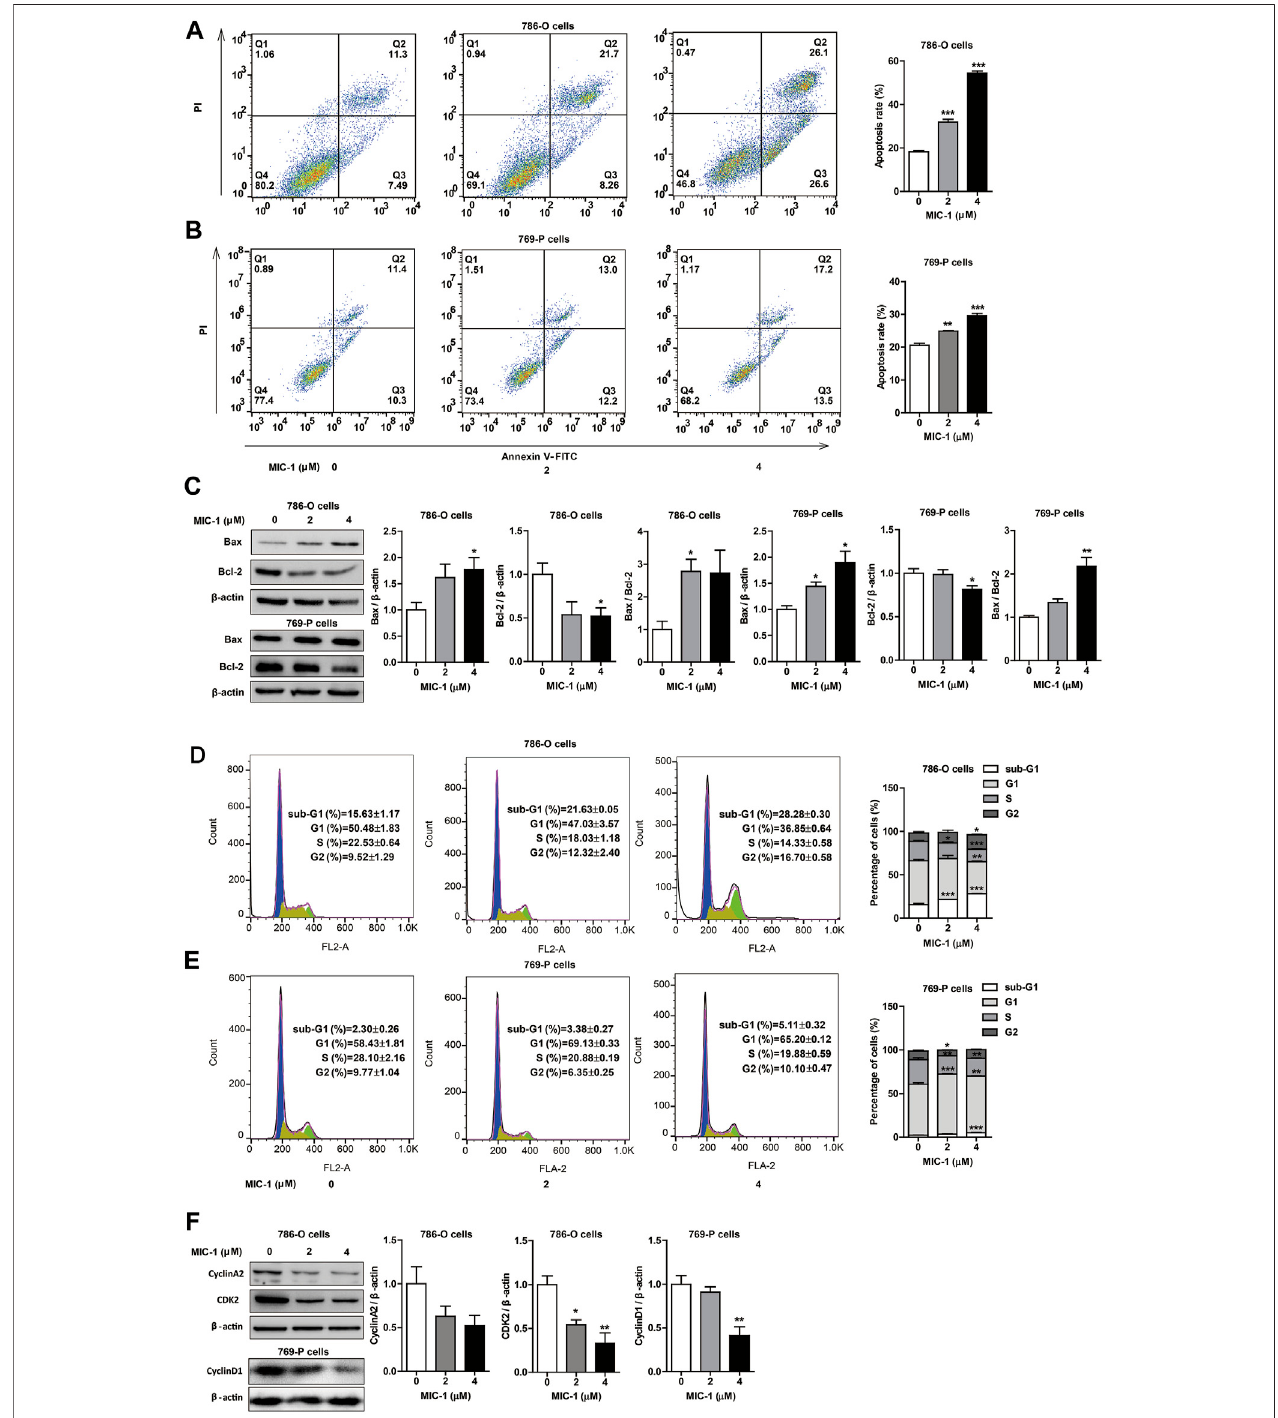
FIGURE 3 | MIC-1 induces apoptosis and cell cycle arrest in RCC cells. 786-O cells and 769-P cells were treated with MIC-1 (0, 2, or 4 μ M) for 48 h (A,B) The cell apoptosis of786-O cellsand 769-P cellswere determined by fl owcytometry. (C) The protein expression ofBaxand Bcl-2 in786-O cellsand 769-P cells were detected by western blotting. β -actin served as a loading control. (D,E) The cell cycle distribution of 786-O cells and 769-P cells were determined by fl ow cytometry. (F) The proteinexpression ofCDK2and cyclinA2 in786-O cells,and theprotein expression ofcyclinD1in769-Pcellsweredetectedbywesternblotting. β -actinserved as a loading control. Values represent the means ± SEM from three independent experiments and statistical analysis was performed by one-way ANOVA; * p < 0.05, ** p < 0.01, *** p < 0.001: MIC-1 compared with the control (0 μ M).